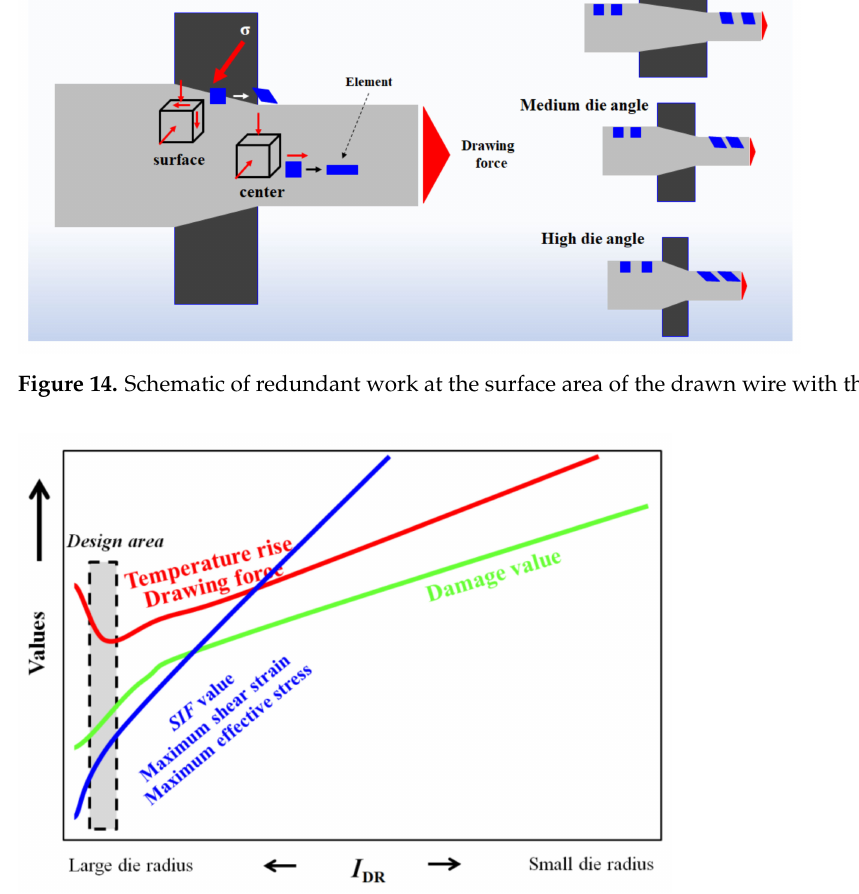
Figure 15. Schematic description of variations in various design factors with I DR